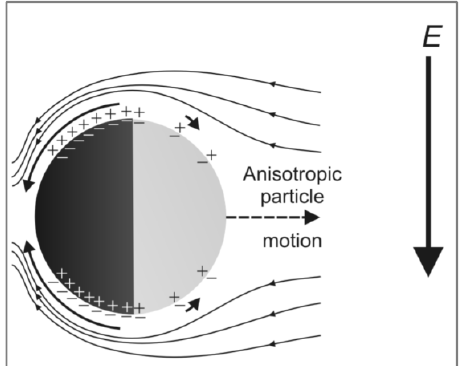
Figure 1. Reproduction of a schematic by Gangwal et al. of a particle in one-half cycle of an AC electric field in the stable configuration. The electric double layer on the gold side (black hemisphere) is more strongly polarized and thus drives a stronger induced-charge-electroosmosis slip (arrows) than the polystyrene side, resulting in induced-charge electrophoresis (ICEP) motion in the direction of the dielectric side. Reprinted with permission [14].